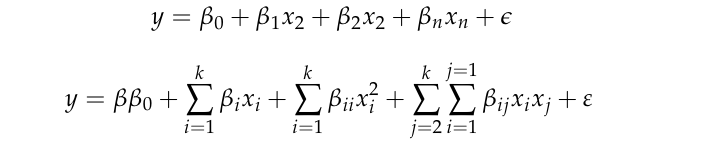
Figure 15. Energy consumption of POFA-ECC mixes.